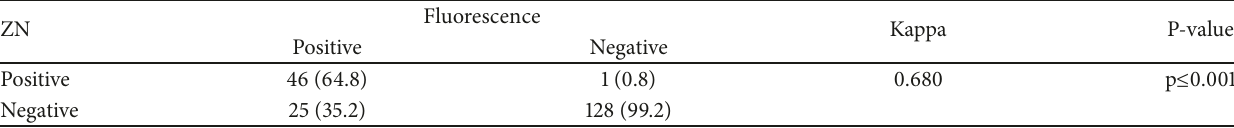
Table 3: Comparison of diagnostic performance of fluorescence staining to ZN staining.